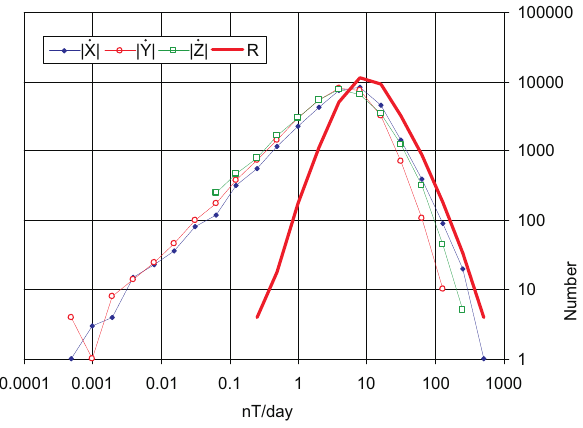
Fig. 1. Histogram of | X 0 | , | Y 0 | , | Z 0 | and R series computed from daily means at